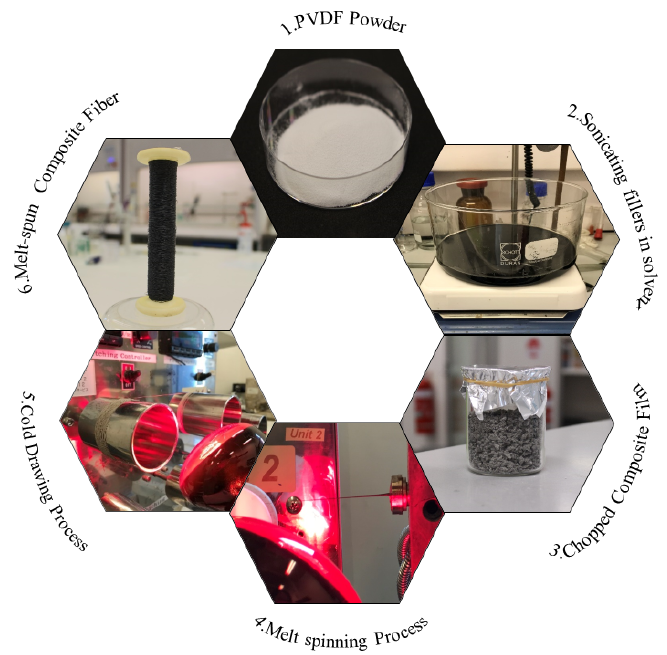
Figure 1. Preparation process of PVDF/rGO nanocomposite fibers.